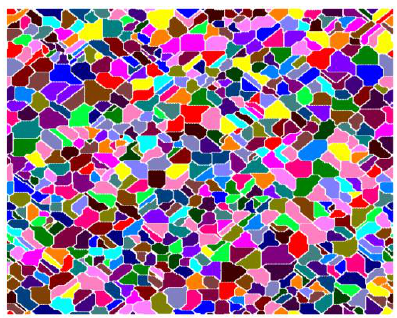
Figure 2. The initial microstructure for AGG.